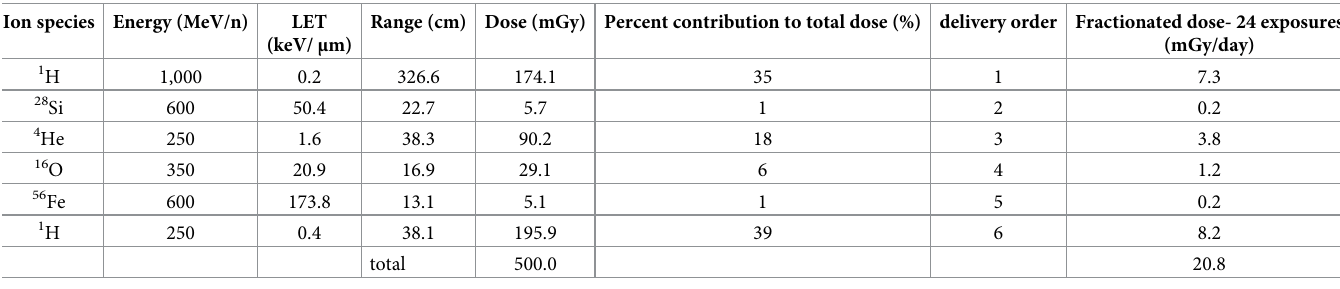
Table 6. Simplified 5-ion mixed field normalized to 500